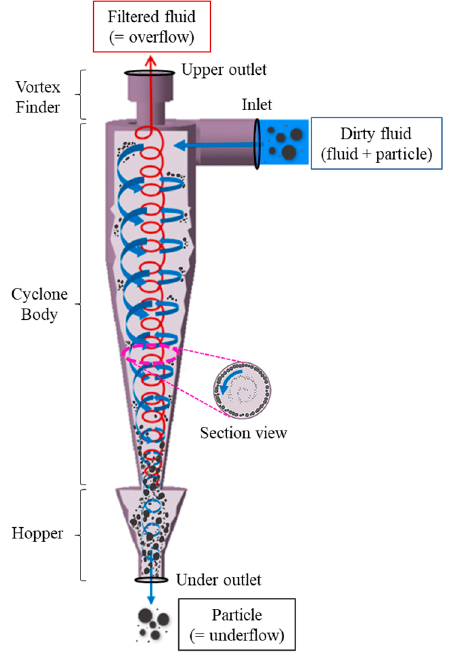
Figure 1. Schematic representation of the cyclone principle.